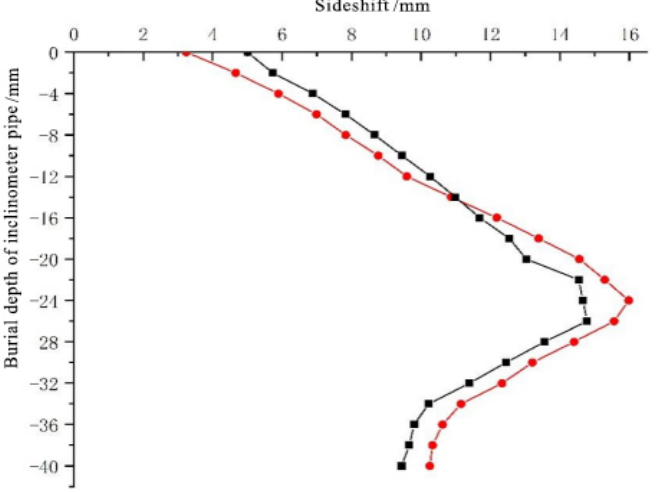
Figure 14. Horizontal displacement contrast curves (red line: simulated value; black line: monitored value).